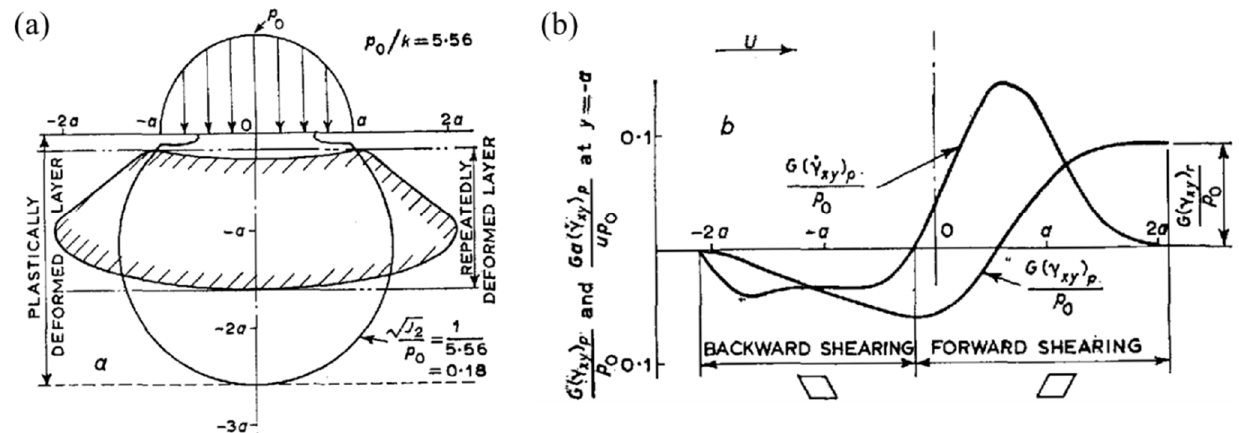
Figure 5. ( a ) Zone of plastic action in the steady state. ( b ) The steady cycle of plastic shear strain, indicating forwarding and backward shearing [8].